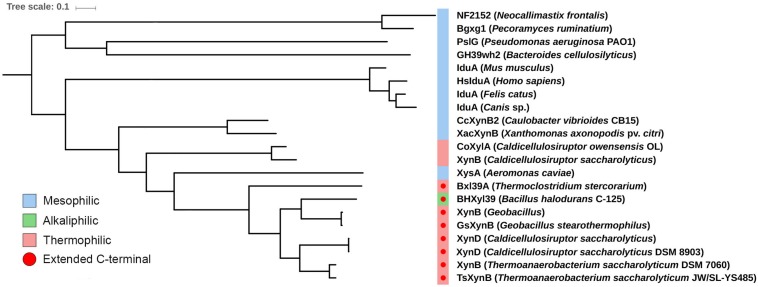
Evolutionary relationship of the C-terminal extension in mesophilic and extremophilic GH39 members. Maximum likelihood phylogenetic tree of characterized GH39 enzymes annotated in CAZy database (Lombard et al., 2014), highlighting the mesophilic, alkalophilic and thermophilic organisms. The C-terminal extension (red circle) is only observed in enzymes from alkalophilic or thermophilic organisms. All nodes have support values >0.7.